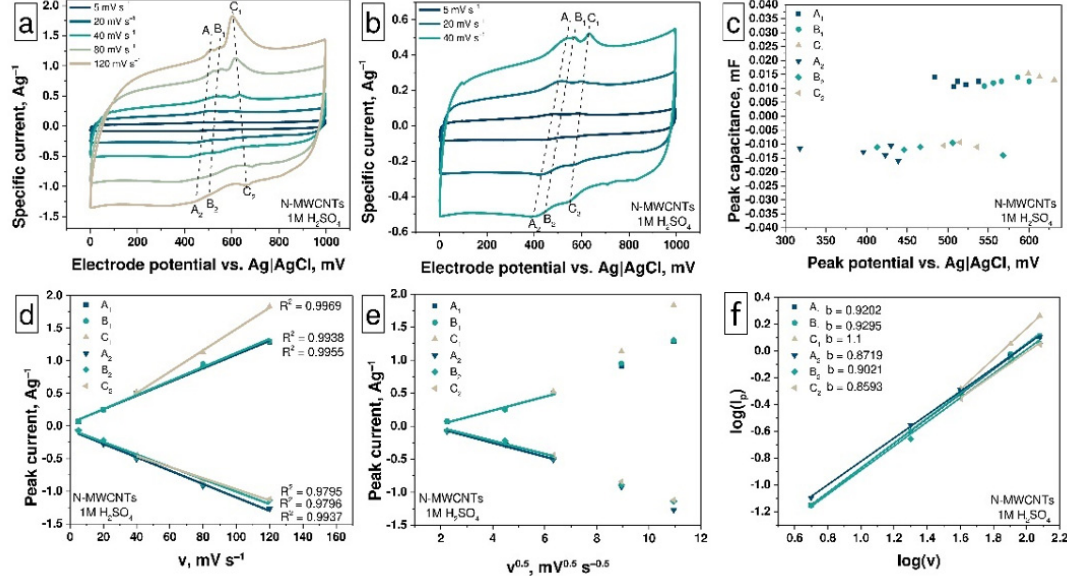
Figure 4. The CV curves at scan rates (v) in the range ( a ) from 5 to 120 mV · s − 1 and ( b ) from 5 to 40 mV · s − 1 ; ( c ) the peak capacitance vs. peak potentials plot; ( d ) scan rate and ( e ) square root of scan rate vs. peak current plots and ( f ) log of scan rate vs. log of peak current plot for as-prepared